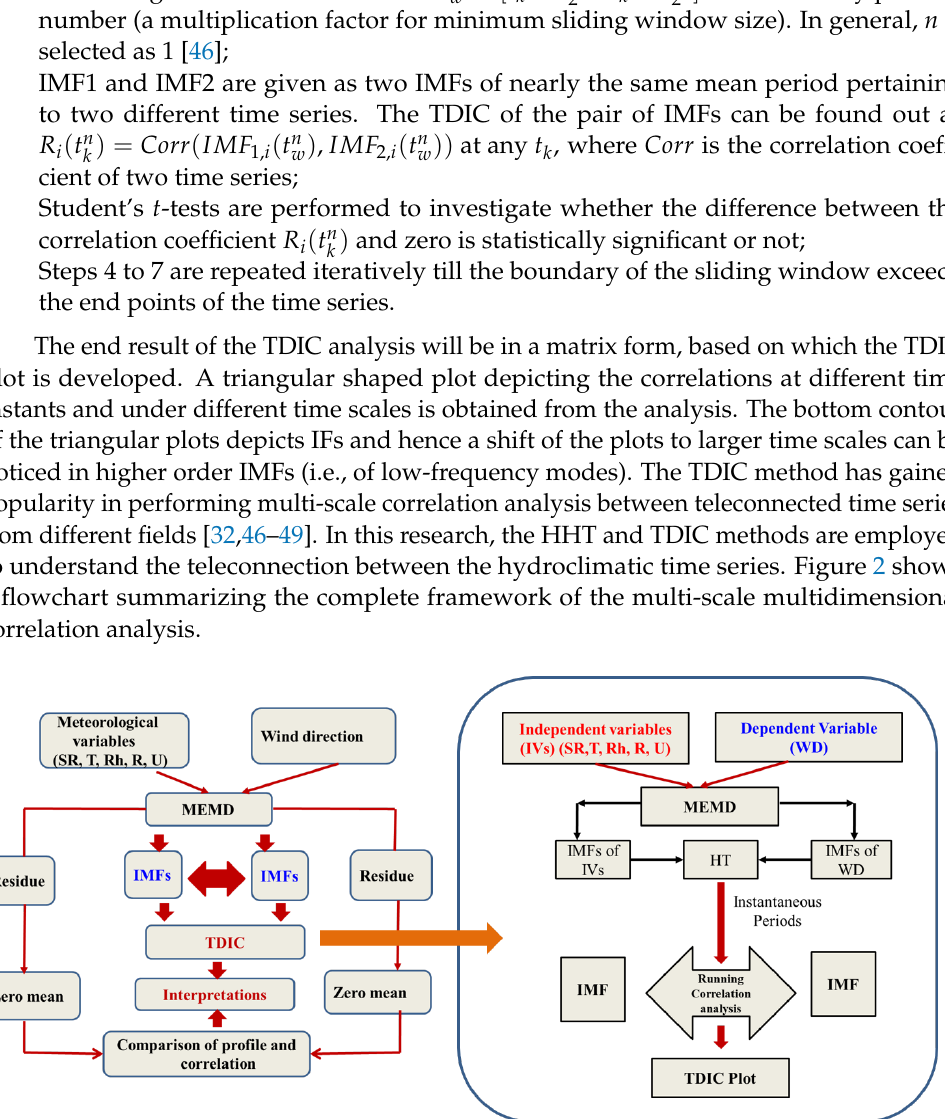
Figure 2. Framework of the multi-scale multidimensional correlation